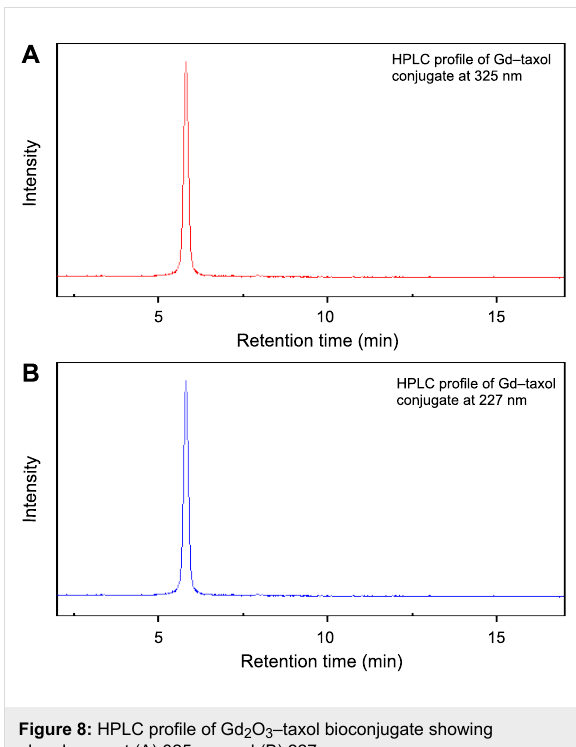
Figure 8: HPLC profile of Gd 2 O 3 –taxol bioconjugate showing absorbance at (A) 325 nm and (B) 227